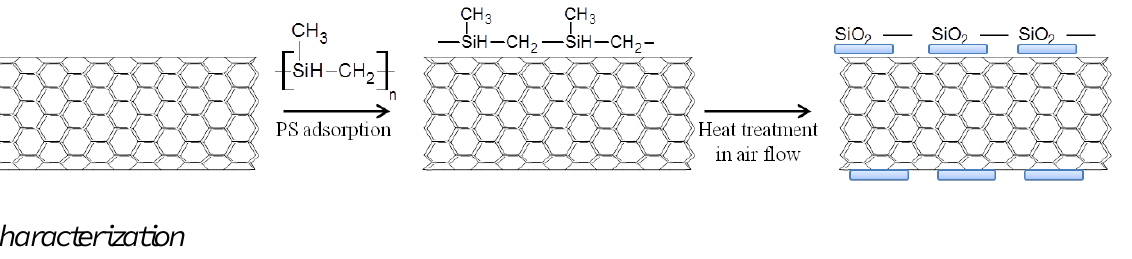
Figure 1. Schematic diagram of the SiO by Polycarbomethylsilane (PS) coating and heat